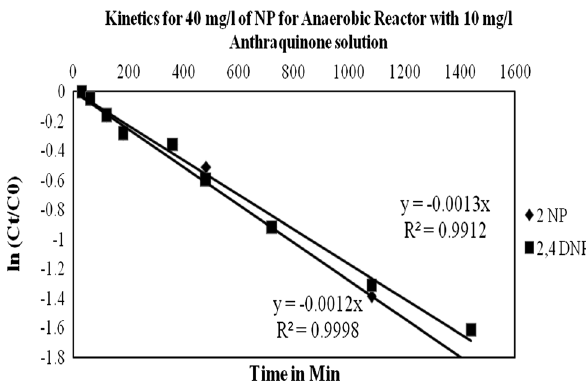
Fig. 16 Kinetics for 40 mg/l nitrophenol loading with 10 mg/l AQSA solution